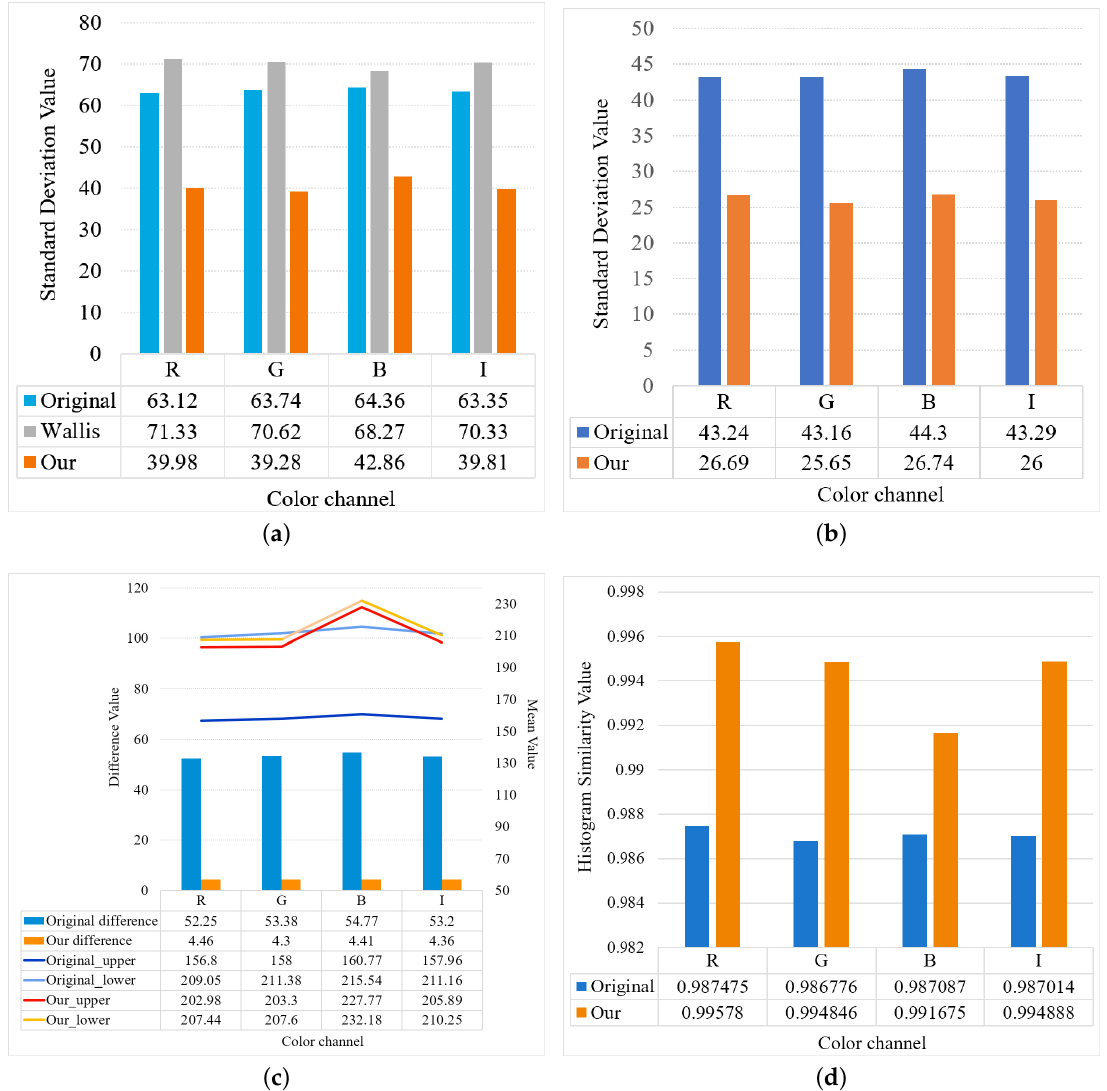
Figure 14. Statistical results for the color consistency processing between images. ( a ) The standard deviation values of the mosaic results of the original images, the Wallis method results, and the results of the proposed method. ( b ) The standard deviation values of the mosaic results of the details of the original images and the details of the results of the proposed method. ( c ) The mean values and the difference values of the upper and lower part of the details of the original images and the details of the results of the proposed method. ( d ) The histogram similarity values between the upper part and the lower part of the mosaic result of the details of the original images and the mosaic result of the details of the proposed